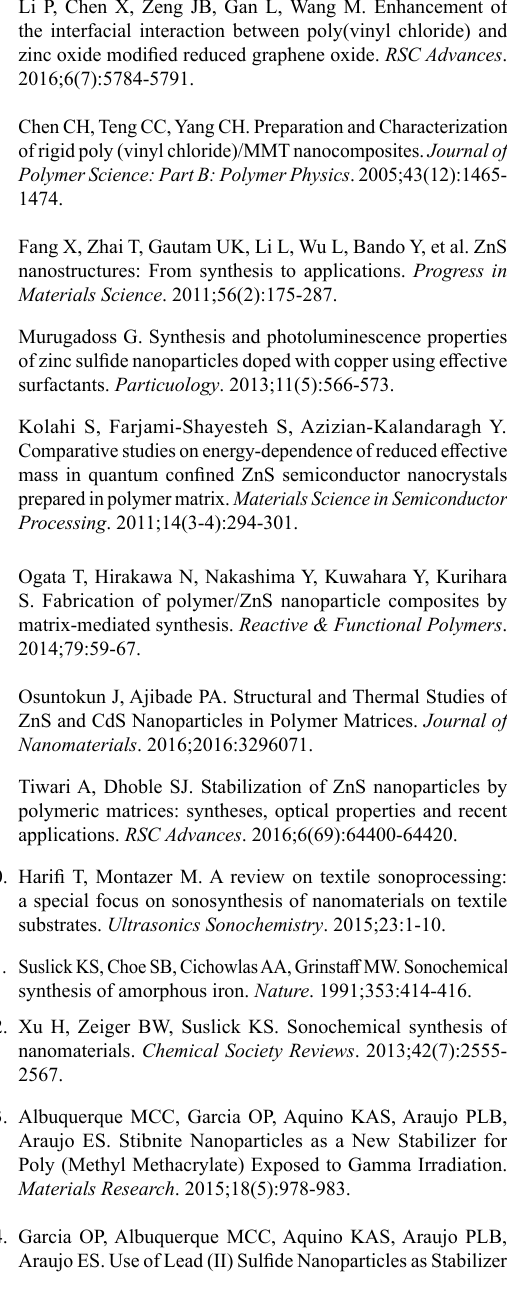
Means with the same letter in the same column do not differ with p <0.05 for the Student's